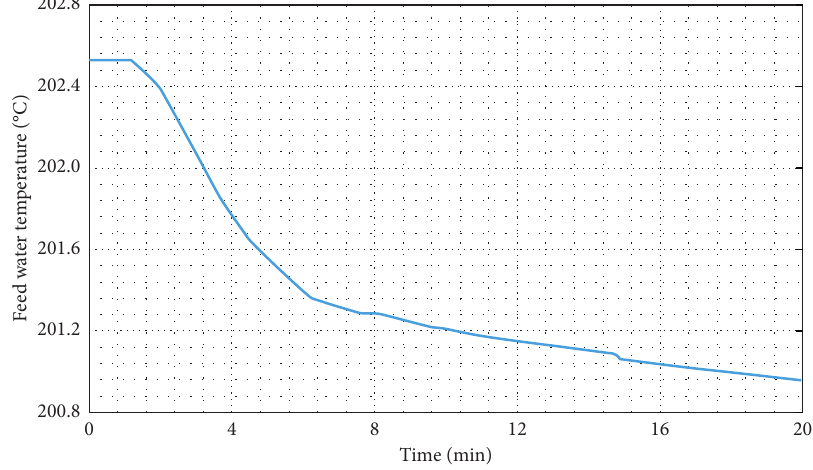
Figure 18: Feedwater temperature in case 2.